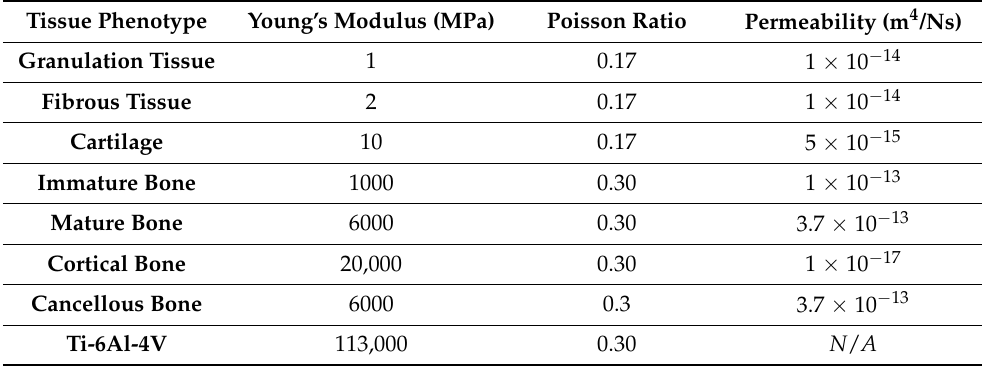
Table A2. Material property setups in the current study [3].